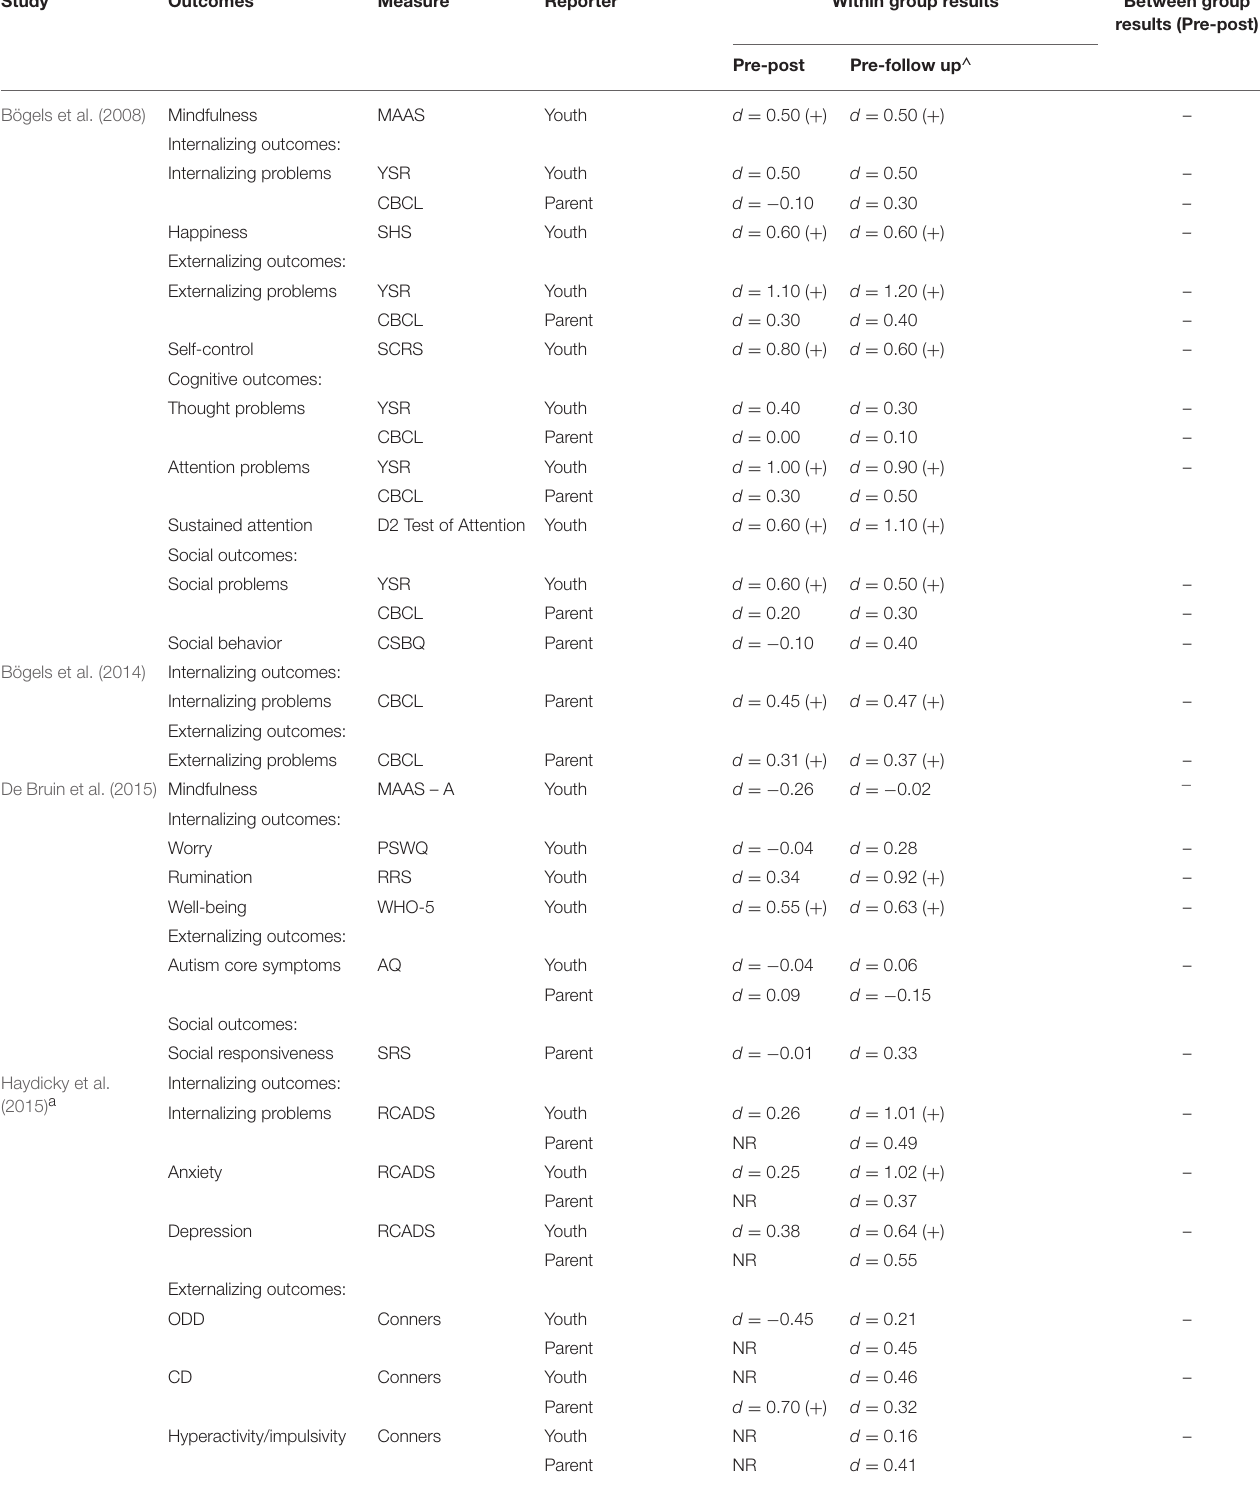
TABLE 3 | Reported results of mindfulness intervention, for youth psychological outcomes. Study